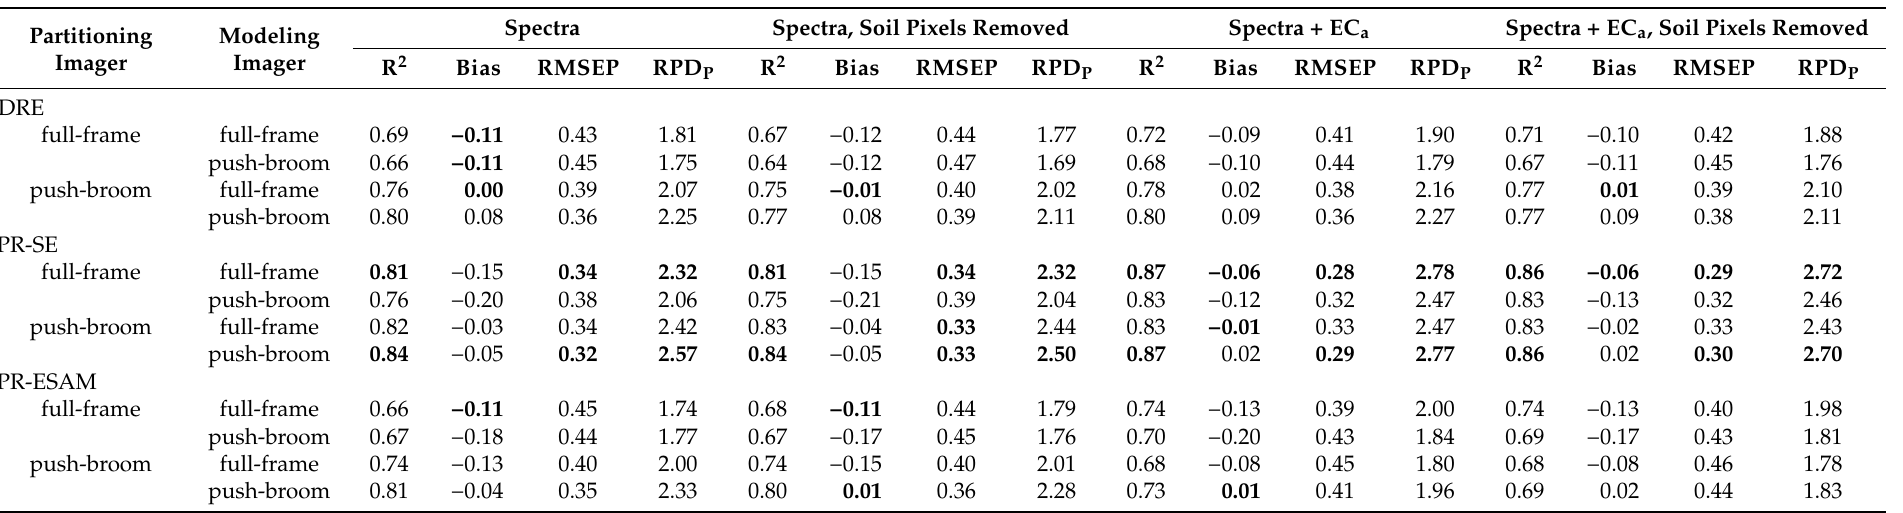
Table 4. Nitrogen uptake prediction performance metrics of individual model families across the testing datasets according to the device which provided spectra for dataset partitioning and for model training. The four column blocks examine the effects of removing soil pixels from the hyperspectral imagery prior to model training or augmenting the spectral data with measurements of apparent soil electrical conductivity. The three row blocks correspond to the predicted variables. The values of bias and RMSEP are in gm − 2 . The individual rows of each block compare the performance of the cameras and predictive model formulations. The results with the best metrics for each training dataset are marked in